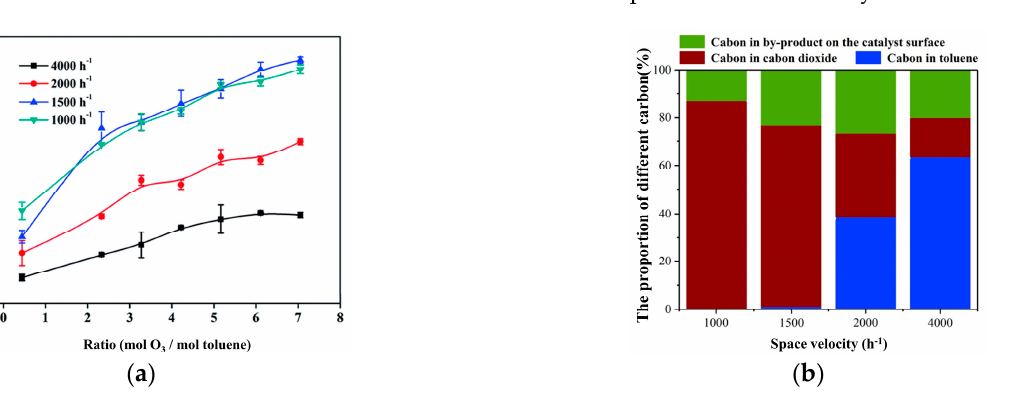
Figure 8. ( a ) Removal of toluene at different space velocities with ZnFe 2 O 4 /g-Al 2 O 3 catalyst; ( b ) impact of space velocity on carbon balance. Reprinted with permission: Royal Society Chemistry 2020 [44].